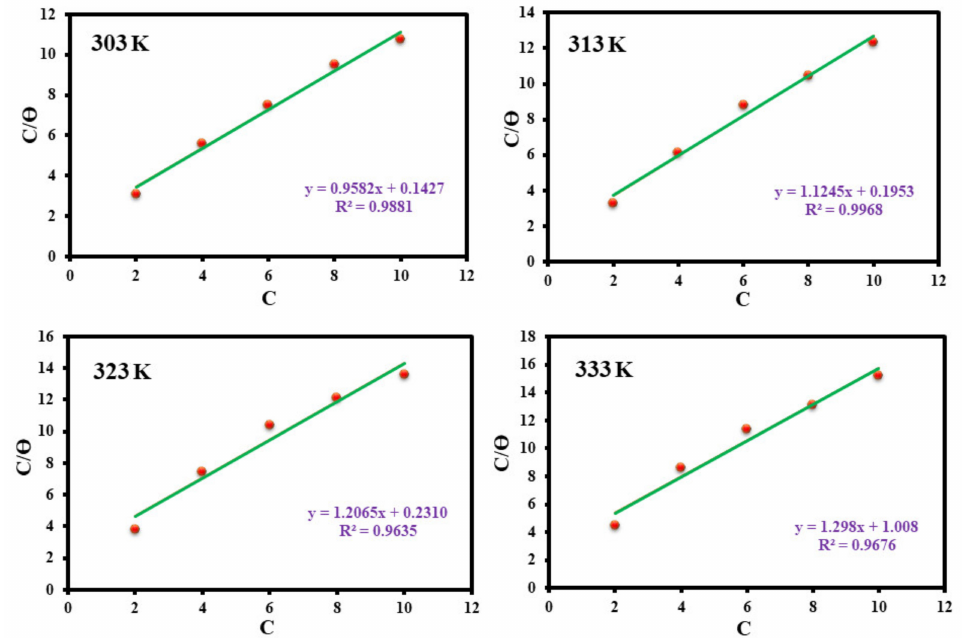
Figure 4. Langmuir adsorption isotherm for the inhibition effect of aqueous leaves extract of SA on mild steel corrosion in 1.0 M HCl at different temperatures.